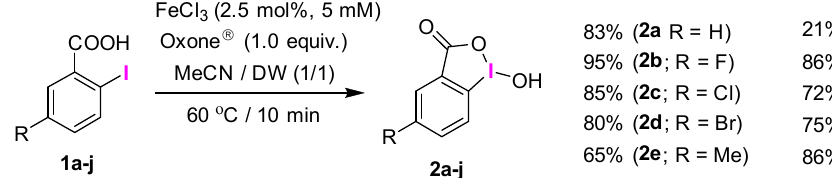
Figure 5. Optimization of ( a ) temperature using 1.0 equivalent of Oxone ® and ( b ) amount of Ox- one ® at 60 °C for the synthesis of IBA 2a from 2-IB 1a in the presence of 2.5 mol% FeCl 3 (MeCN/DW